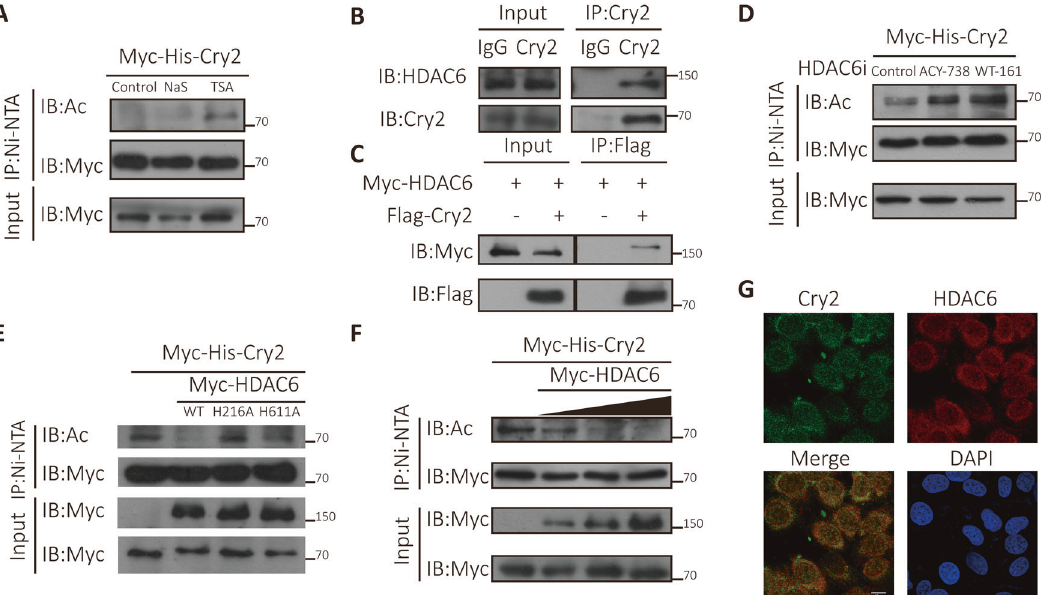
Fig. 2 The KDAC of Cry2 is HDAC6. A HDACs inhibitors increased Cry2 acetylation. B Endogenous interaction between Cry2 and HDAC6 in MCF7 cells. C Exogenous interaction between Cry2 and HDAC6 in HEK293T cells. D HDAC6 inhibitors increased Cry2 acetylation. E HDAC6 inhibited Cry2 acetylation depend on its KDAC activity. F HDAC6 decreased Cry2 acetylation in a dose-dependent manner. G Cry2 and HDAC6 were colocalized in the cytoplasm in MCF7